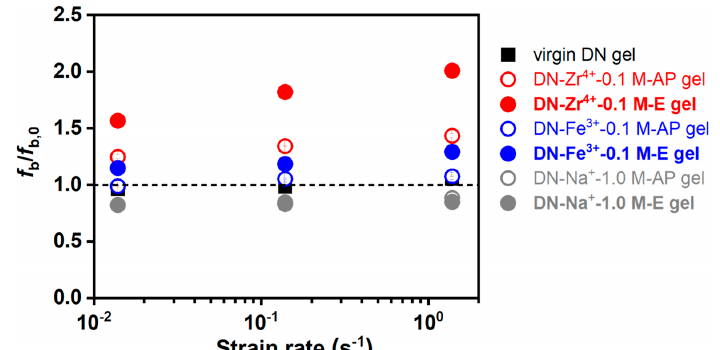
Figure 9. The ratio of breaking force of first network strands f b / f b,0 for various DN hydrogels relative to the virgin DN gels. The f b and f b,0 represent the breaking force of first network in various DN hydrogels and the virgin DN gels, respectively.